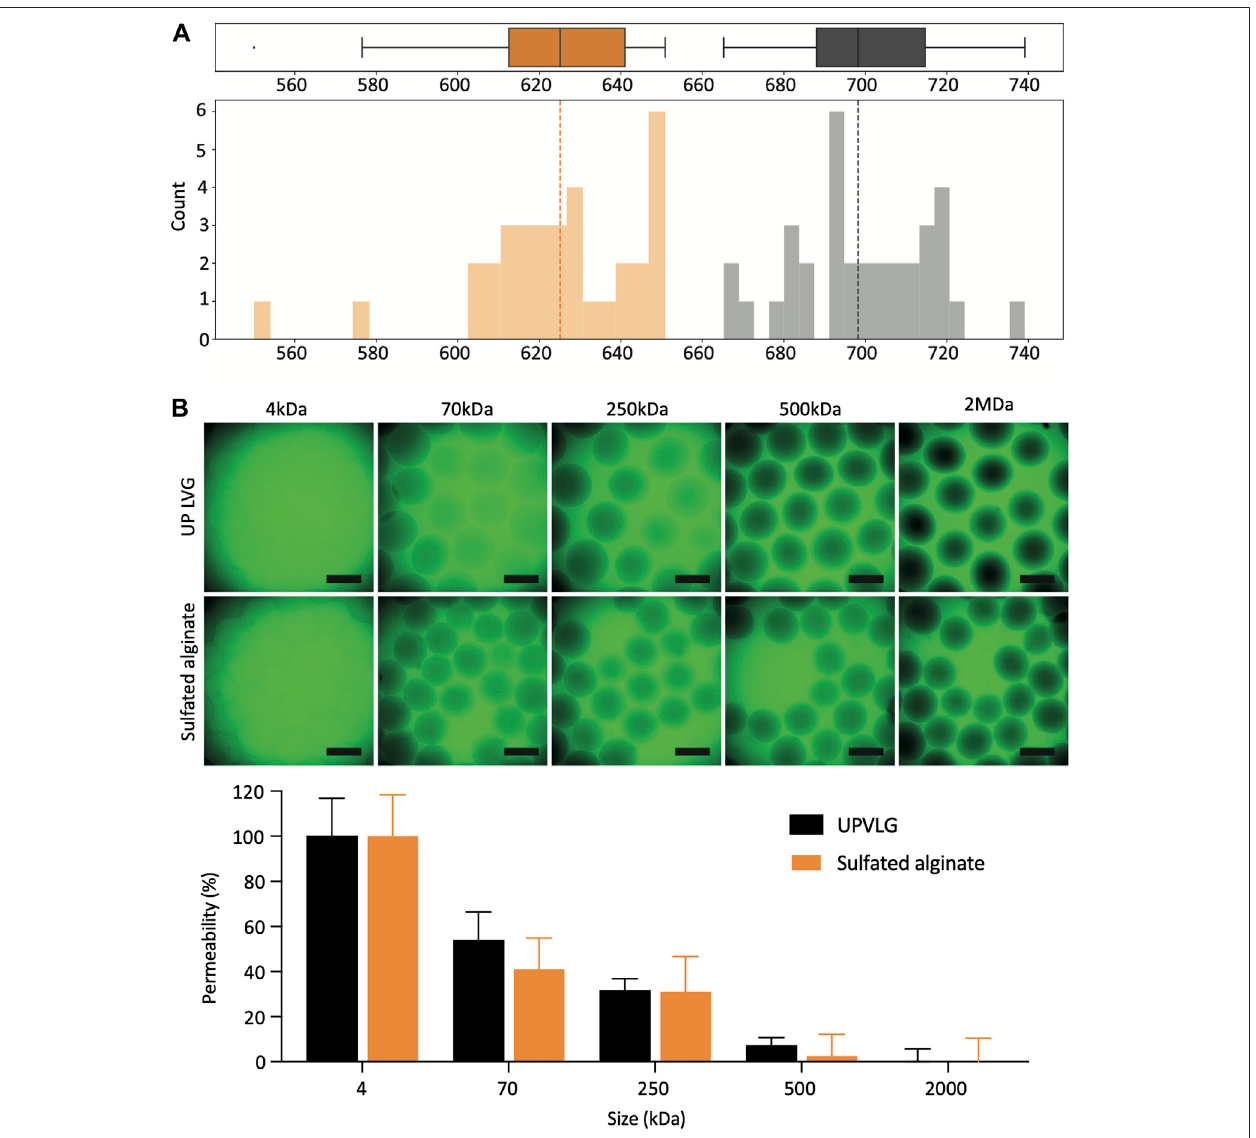
FIGURE 2 | Characterization of sulfated alginate microbeads. (A) Size distribution of encapsulated hPSC-Hep spheroids. The boxplots and histograms represent the diameter measurements of unmodi fi ed UP-LVG (gray; n (cid:1) 34) and sulfated alginate (orange; n (cid:1) 34). The dashed lines represent the median microbead diameter for each alginate type. (B) Permeability of the unmodi fi ed UP-LVG and sulfated alginate microbeads ( n (cid:1) 11). Selection of representative CLSM images showing different degrees of permeation of FITC-dextran probes at different molecular weights (top). Quanti fi cation of FITC-dextran permeation normalized to 4 kDa (100% permeation) and 2 MDa (0% permeation) (bottom). Scale bars: 500 μ m. (*p <